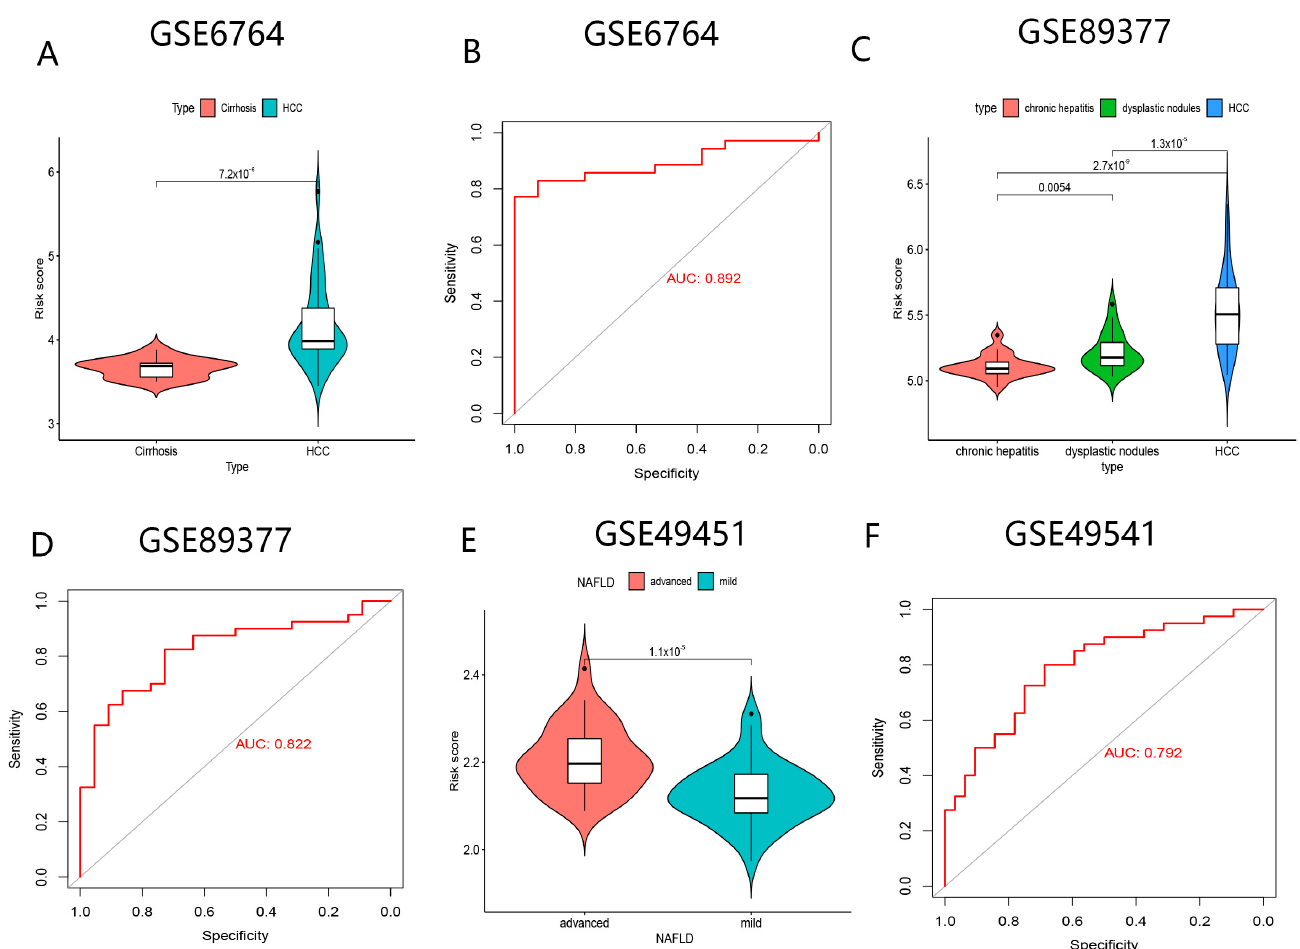
Figure 12. The power of BMGs for early detection the risk of HCC. ( A ) Comparison of risk scores between cirrhosis and HCC. ( B ) The ROC curve of risk score distinguishing from HCC and cirrhosis. ( C ) Comparison of risk score in cirrhosis, dysplatic node disease, and HCC. ( D ) The ROC curve of risk score distinguishing from dysplastic nodule disease and HCC. ( E ) Comparison of risk score in early and advanced steatohepatitis. ( F ) The ROC curve of risk score distinguishing from early steatohepatitis and advanced steatohepatitis.